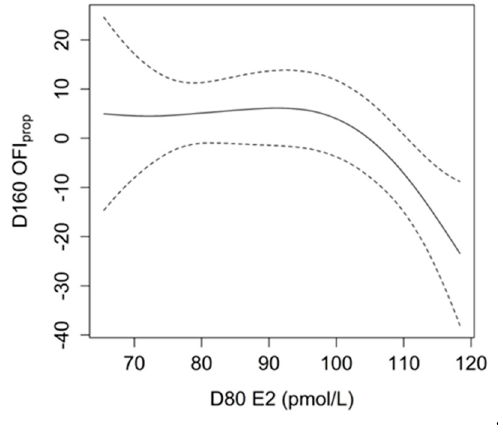
Figure 4. Smoothing spline showing the relationship between serum oestradiol (E2) levels at 80 days of age (D80) and the Ovarian Follicle Index of follicle proportion (OFI prop ) values in non-cycling gilts at D160 with Bayesian confidence intervals. Greater serum E2 levels corresponded to lower OFI prop values ( p = 0.027, Adj-R 2 = 0.14), which represents ovaries with a smaller ratio of primary and secondary follicles to preantral, antral and atretic follicles.